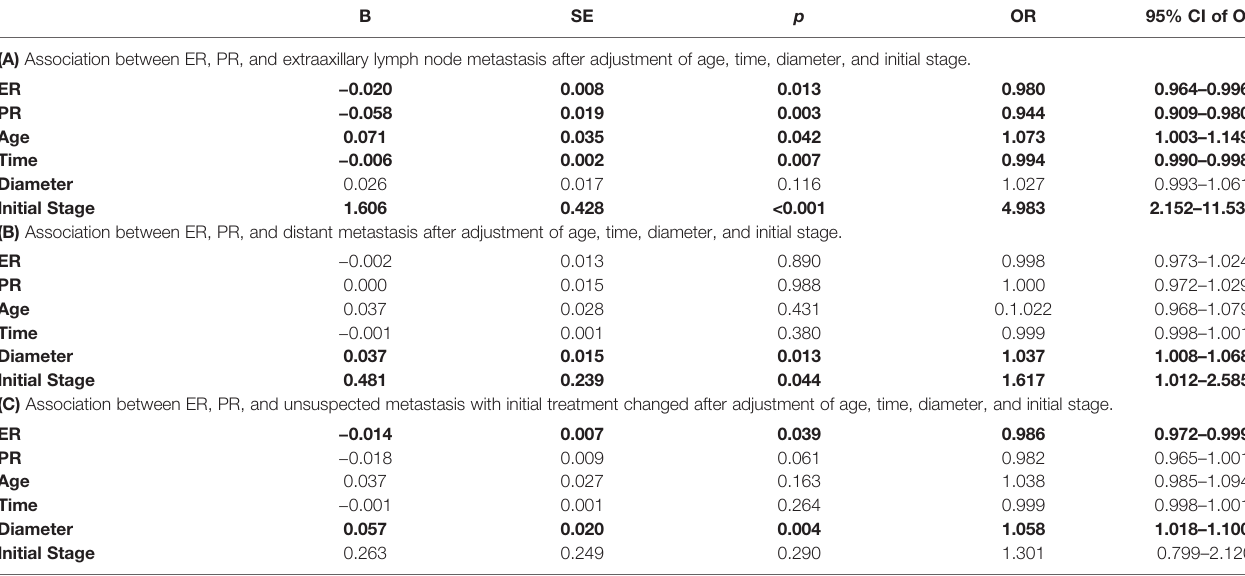
TABLE 3 | Association between ER, PR, and N1, M1, C1 by logistic regression. B SE p OR 95% CI of OR (A) Association between ER, PR, and extraaxillary lymph node metastasis after adjustment of age, time, diameter, and initial stage. ER − 0.020